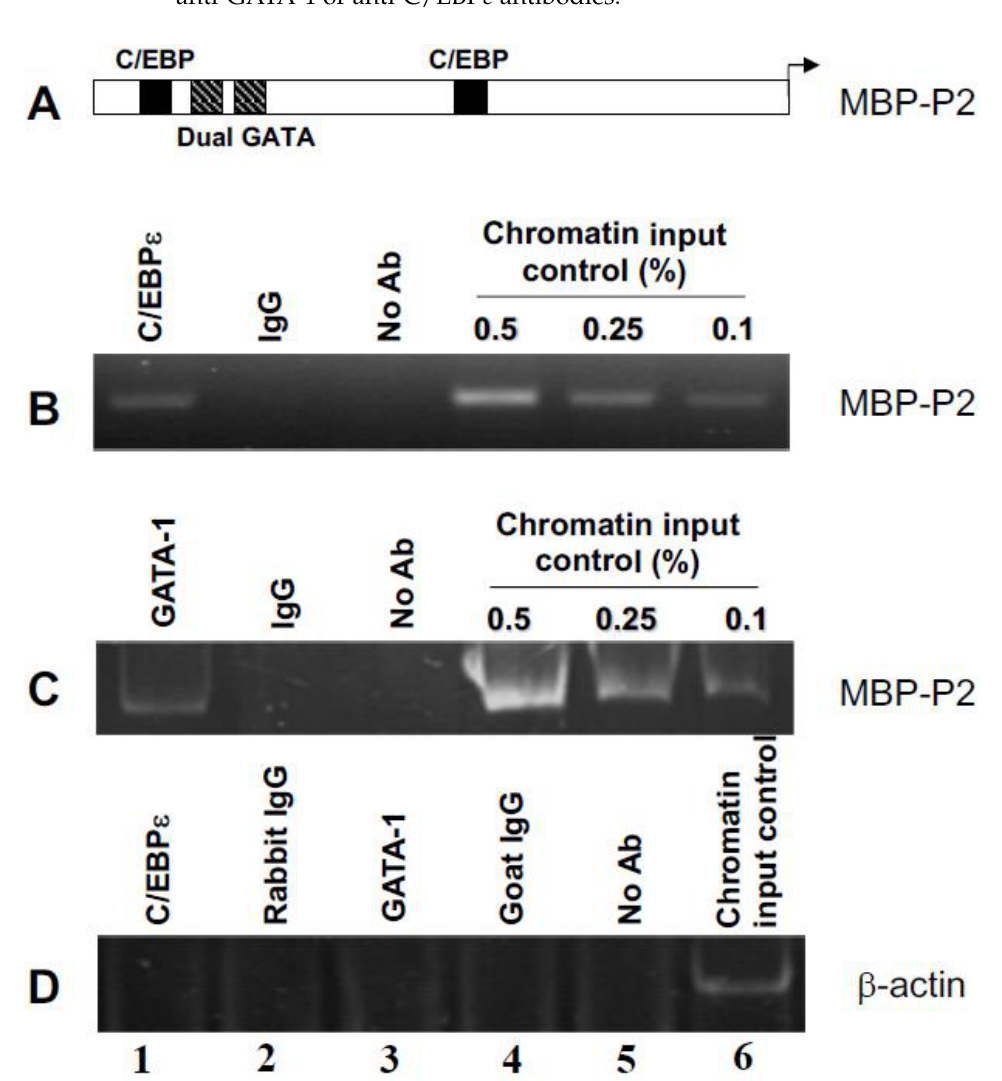
Figure 1. Chromatin immunoprecipitation of the MBP promoter from AML14.3D10 eosinophils demonstrates in vivo occupancy of the P2 promoter by C/EBP ε and GATA-1. Structure of the MBP1-P2 promoter with two functional C/EBP sites and the high-affinity double GATA site is shown in ( A ). The MBP1-P2 promoter was analyzed by ChIPs ( B , C ) from nuclei of the AML14.3D10 eosinophil myelocyte line that constitutively expresses MBP1 mRNA and protein. ChIP analyses using antibodies to C/EBP ε ( B ), and GATA-1 ( C ) demonstrate the in vivo binding of these factors to the endogenous MBP1-P2 promoter. Negative controls included non-immune IgG and no antibody addition as indicated. Amplification of the human β -actin gene was used as a negative control for the non-specific immunoprecipitation of DNA ( D ). Comparisons to chromatin input of 0.1–0.5% are indicated for the C/EBP ε and GATA-1 ChIPs ( B , C ) and 0.5% for the β -actin control ( D